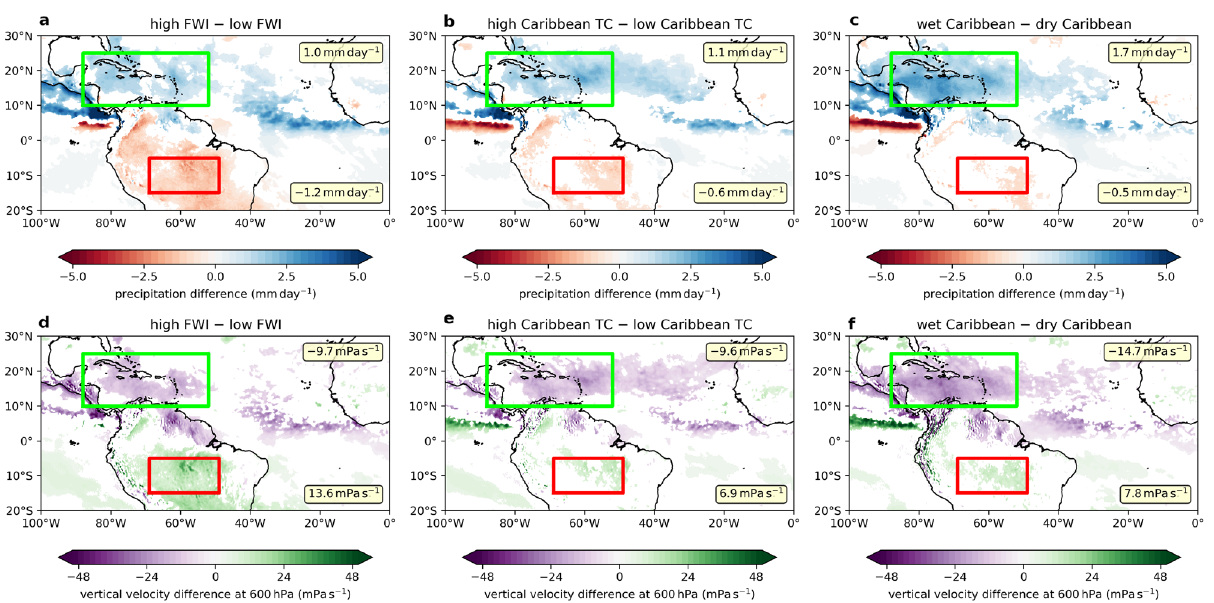
Figure 6. Thermal direct cell between the Caribbean and the Amazon. ( a )–( c ): Composite difference (significant at 95% confidence interval) for ASO precipitation of the top and bottom 13 years between 1980 and 2019 ranked by ( a ) ASO Amazon FWI, ( b ) ASO Caribbean tropical storm count and ( c ) ASO Caribbean precipitation. Average precipitation difference (significant at 95% confidence interval) over the Caribbean and the Amazon are given in the upper right and lower right respectively. ( d )–( f ): Same as ( a )–( c ) except for vertical velocity at 600 hPa